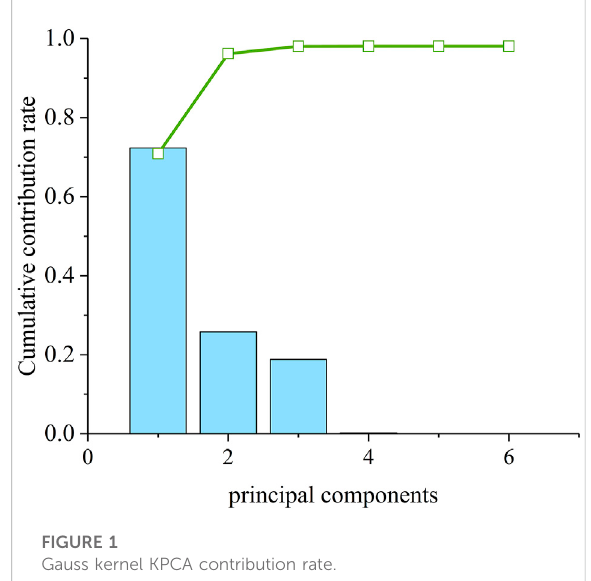
FIGURE 1 Gauss kernel KPCA contribution